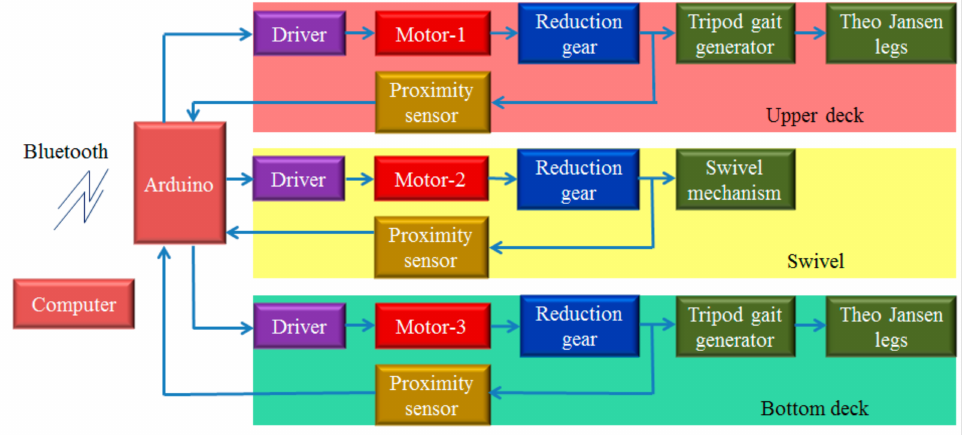
Figure 14. Block diagram of mechatronic